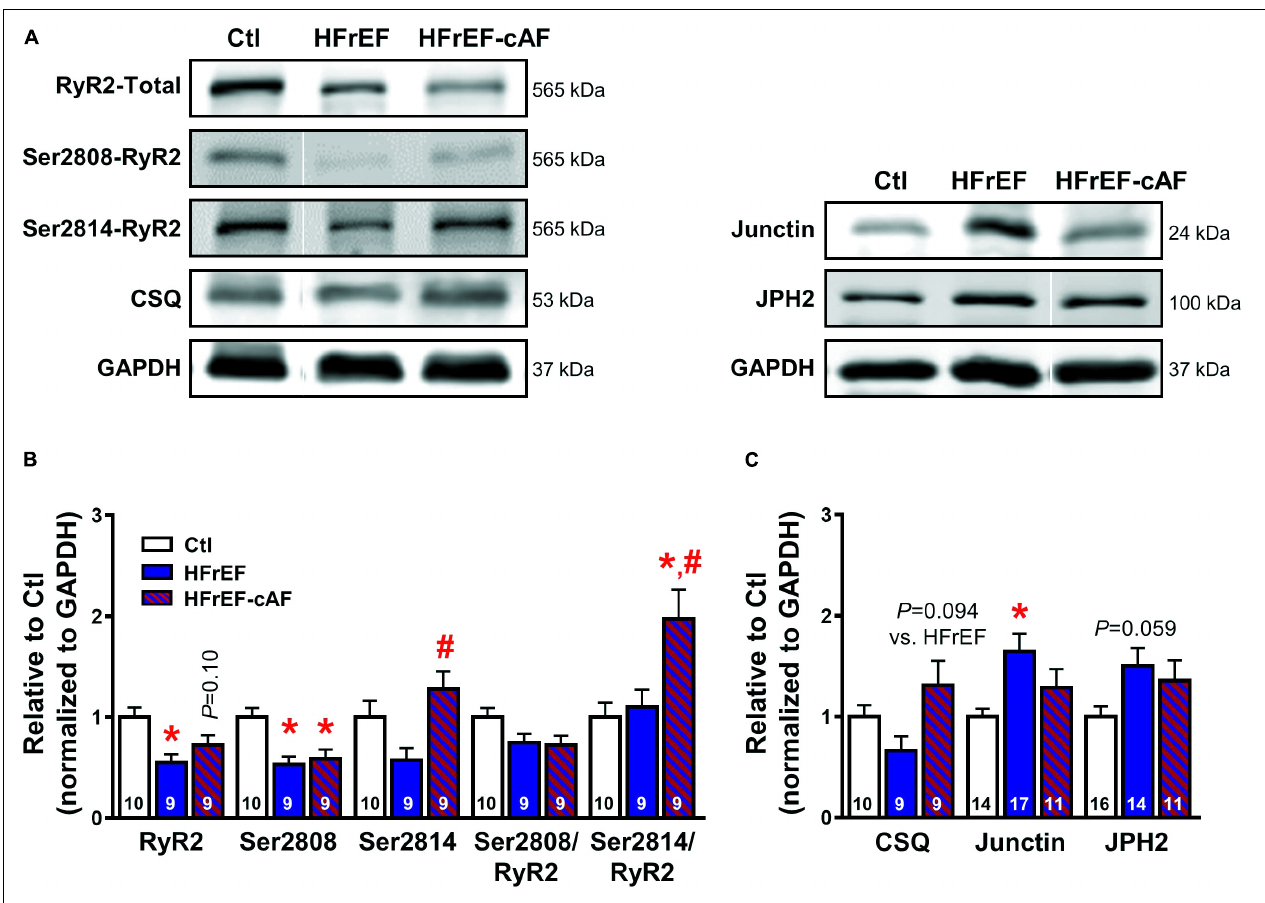
FIGURE 8 | Molecular determinants of ryanodine receptor type-2 (RyR2) dysfunction. (A) Representative Western blot examples of total RyR2, Ser2808-, and Ser2814-phosphorylated RyR2 and calsequestrin (CSQ; left), as well as junctin and junctophilin-2 (JPH2; right) protein expression levels. GAPDH was used as loading control. (B) Quantification of total RyR2, Ser2808-, and Ser2814-phosphorylated RyR2, Ser2808/total RyR2, and Ser2814/total RyR2 protein expression levels in Ctl (white bars), HFrEF (blue bars) and HFrEF-cAF (red/blue-striped bars) patients. (C) Protein expression levels of the RyR2-interacting proteins CSQ, junctin, and JPH2 in Ctl, HFrEF and HFrEF-cAF patients. Data are shown relative to Ctl. Numbers in bars indicate number of patients. ∗ indicates P < 0.05 vs. Ctl, # indicates P < 0.05 vs.